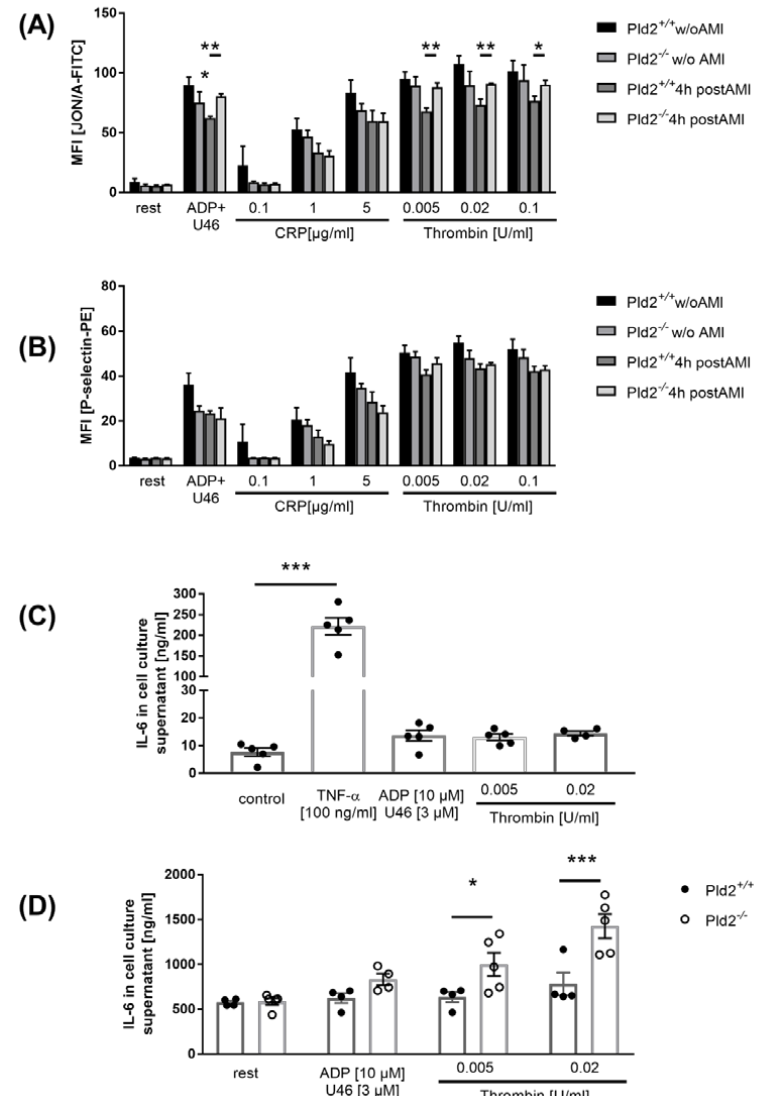
Figure 2. Platelet activation and platelet-induced IL-6 release of endothelial cells were determined. ( A , B ) Murine platelets were isolated 4 h after I / R and incubated with classical agonists. ( A ) Integrin a IIb β 3 activity and ( B ) P-selectin expression were measured by flow cytometry, n = 5. ( C,D ) Quantitative analysis of IL-6 release of the endothelia cell line MHEC5-T stimulated with either 100 ng / mL TNF- α (positive control) or 10 µM ADP , 3 µM U46619, 0.005 and 0.02 U/mL thrombin in the absence ( C ) or presence ( D ) of platelets. Statistical analysis was performed using a two-tailed Student’s t -test ( A,B ) and a one-way ANOVA with Dunnett’s post-hoc test ( C ) or a two-way ANOVA with Sidak’s post-hoc test ( D ), n = 5. Bar graphs depict mean values ± SEM, * p < 0.05, * * p < 0.01, and * ** p < 0.001. Rest = resting, ADP = adenosine diphosphate, CRP = collagen-related peptide, Thr = thrombin, U46619 = thromboxane analog. AMI = acute myocardial infarction.